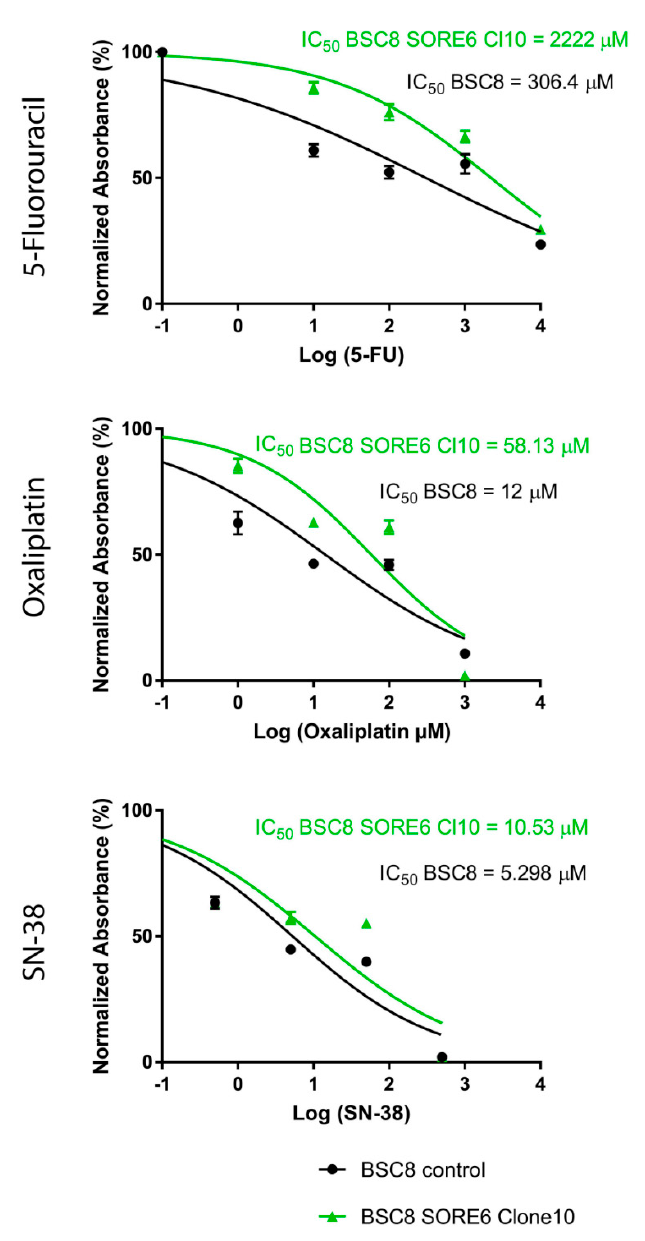
Figure 2. Inhibitory effect of 5-FU, SN-38, and oxaliplatin on cell growth. Cells were treated with increasing concentrations of 5-FU, SN-38, or oxaliplatin for 48 h, and cell viability was determined by the MTT assay. Each point represents the means ± SD. Experiments were performed in biological triplicate with similar results. The survival rate of the BSC8_SORE+/Clone 10 cells was significantly increased (by IC50) following treatment with 5-FU (seven times), SN-38 (five times) and oxaliplatin (6.8 times). Error bars = standard deviation.